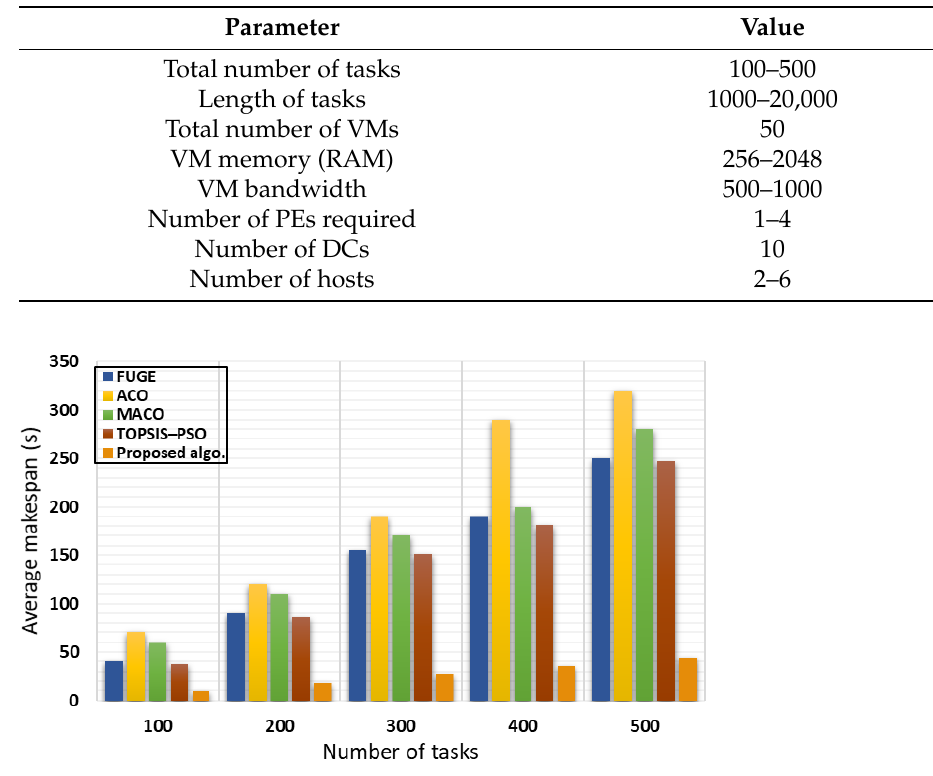
Table 4. Simulation parameters for type 2 experiment.